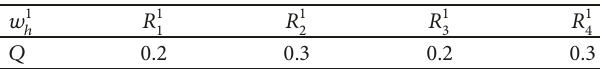
Table 3: The weight of the patients group to the dimensions of